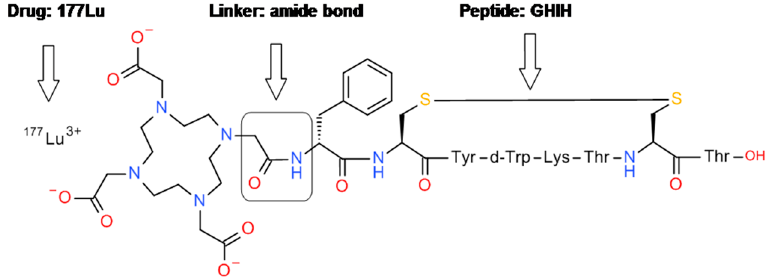
Figure 1. Chemical structure of growth hormone-inhibiting hormone (GHIH)-177Lu conjugate (177Lu-Dotatate).